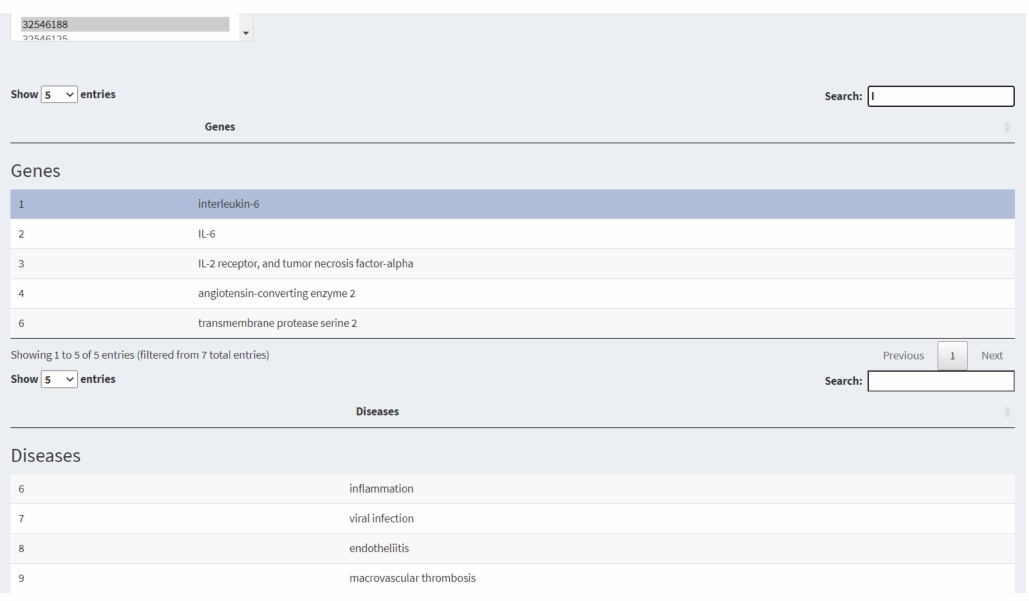
Figure 3. Relevant information , to see the metadata of genes associated with an article, selecting its PubMed ID.